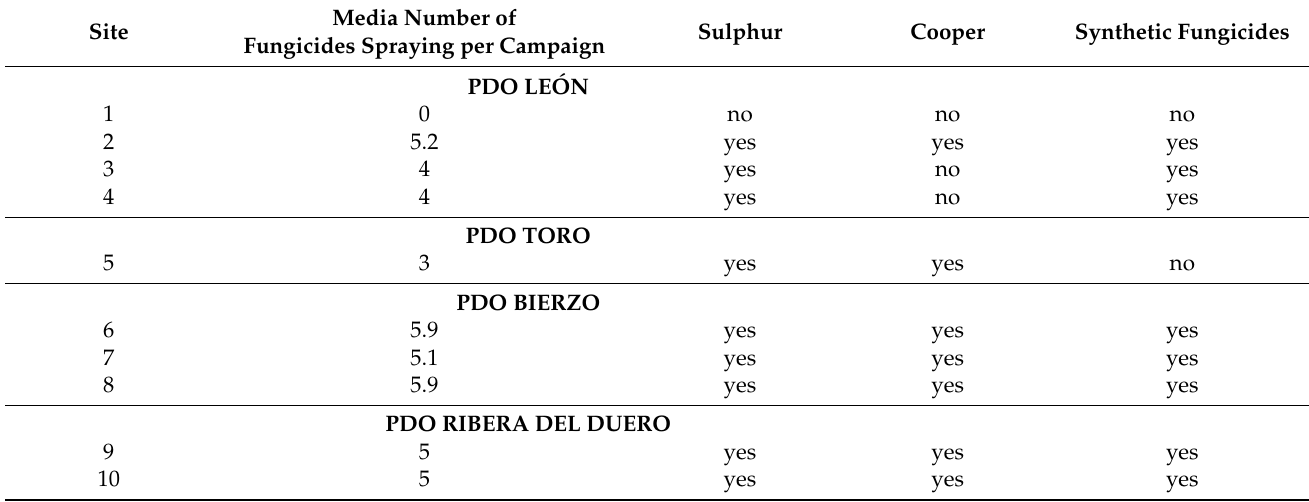
Table 2. Characteristics of fungicides